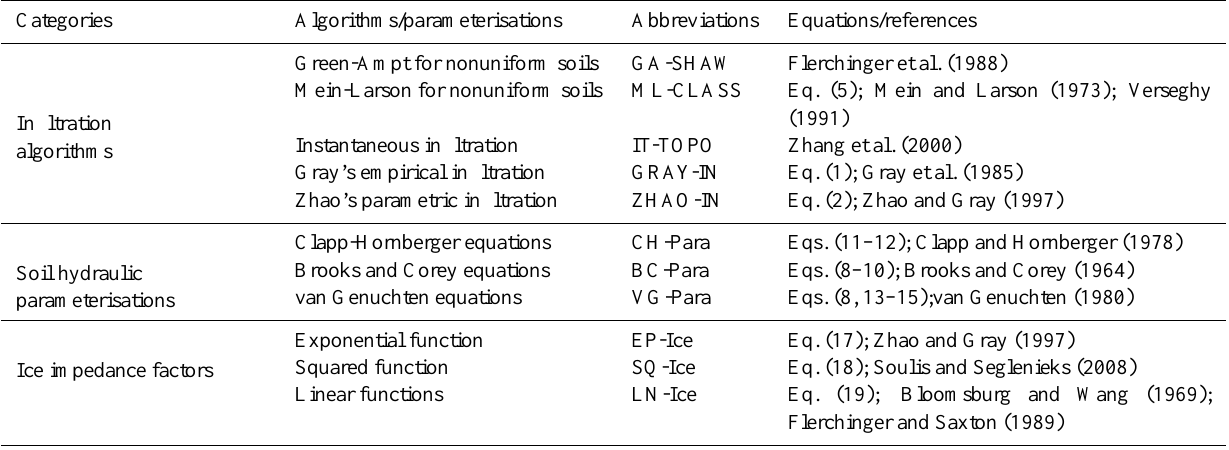
Table 5. Algorithms/parameterisations tested in this study.